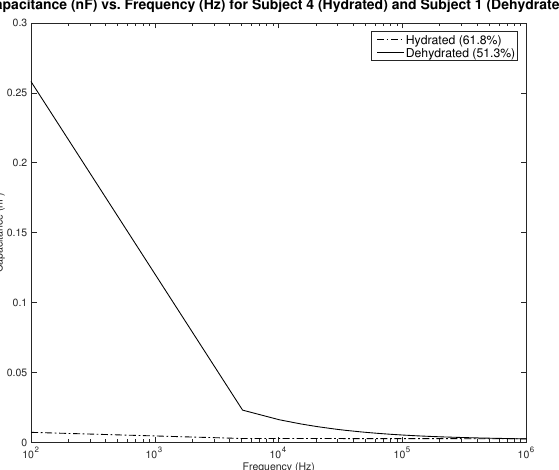
Figure 22. Testing results—capacitance (nF) vs. frequency (Hz) of hydrated and dehydrated subjects (both male).